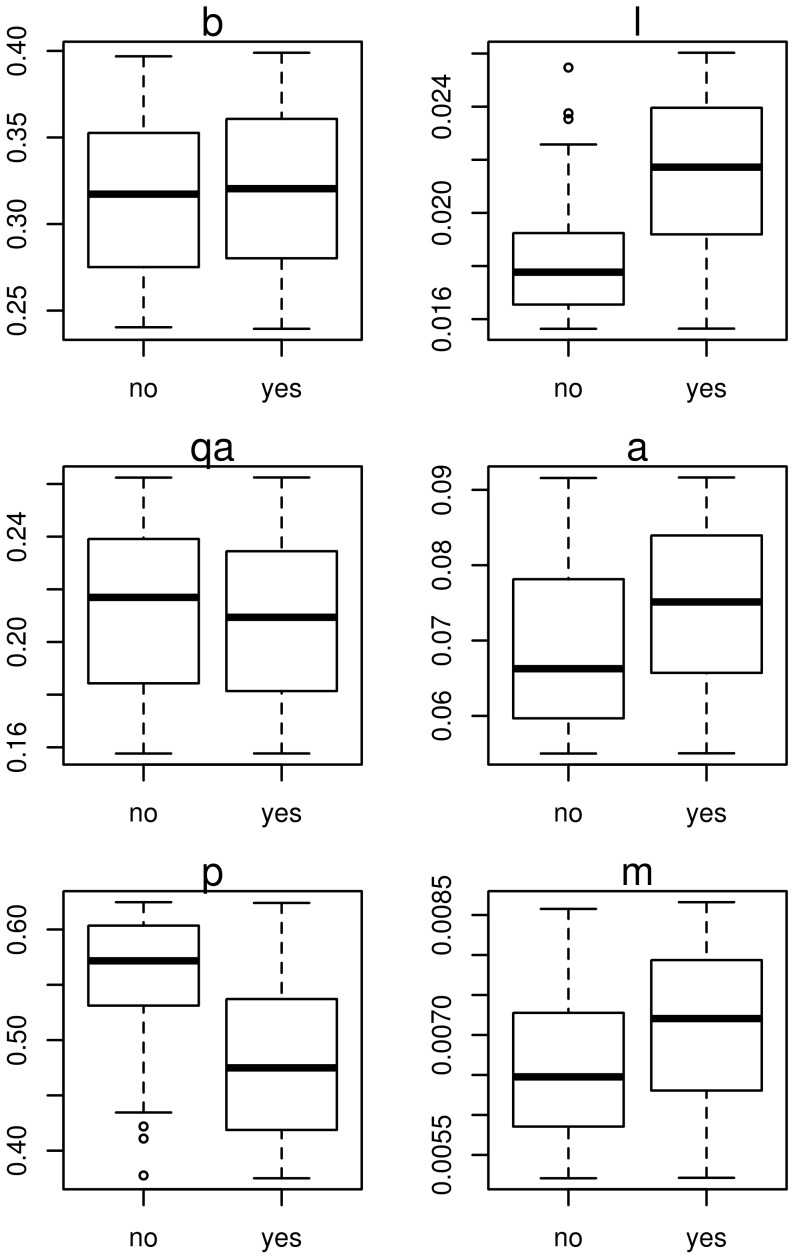
Sensitivity analysis of parameters in Model SEI2D.Box plots comparing parameter values that lead to prediction of successful control (prevalence <1) and failure (prevalence >1) considering a culling program with 4% screening effort and a diagnostic test with 80% sensitivity applied in an area with R0 = 1.41.